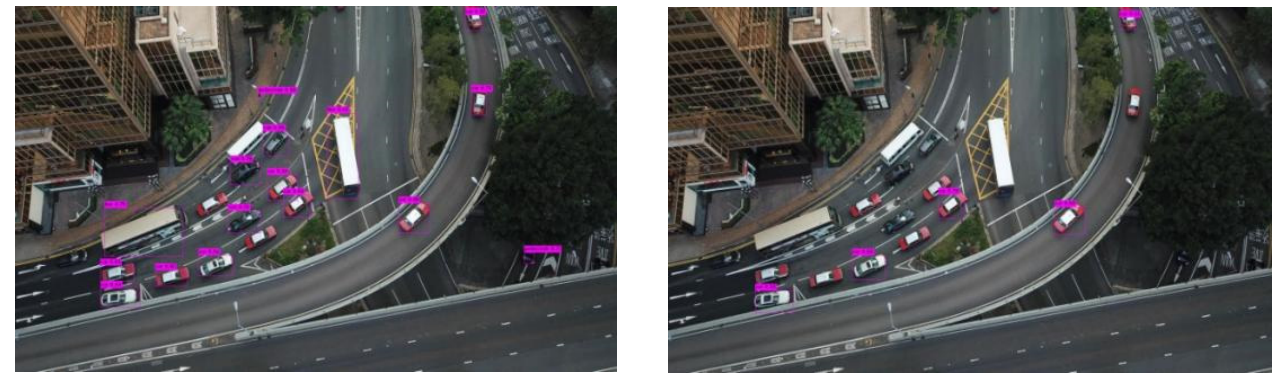
Figure 12. Visual test of small-target detection.